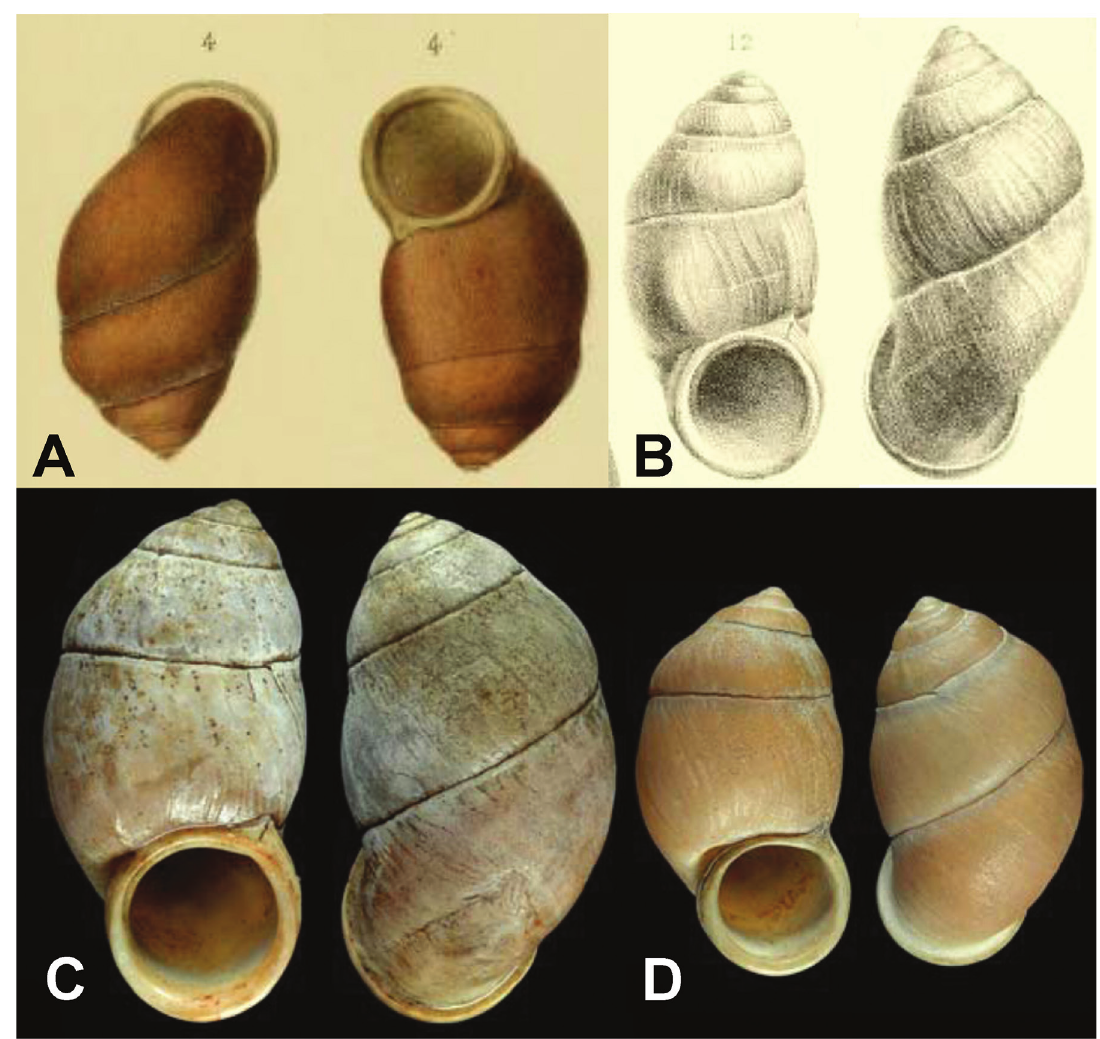
Figure 1. Original illustrations and type material of Vietnamese Pollicaria . A . Pollicaria crossei from Dautzenberg and d’Hamon - ville (1887). B . P. rochebruni from Mabille (1887b). No figure was provided in Mabille (1887a). C . P. rochebruni , lectotype MNHN 21305. D . P. crossei , lectotype MNHN 21304. Lectotype images from Kongim et al.